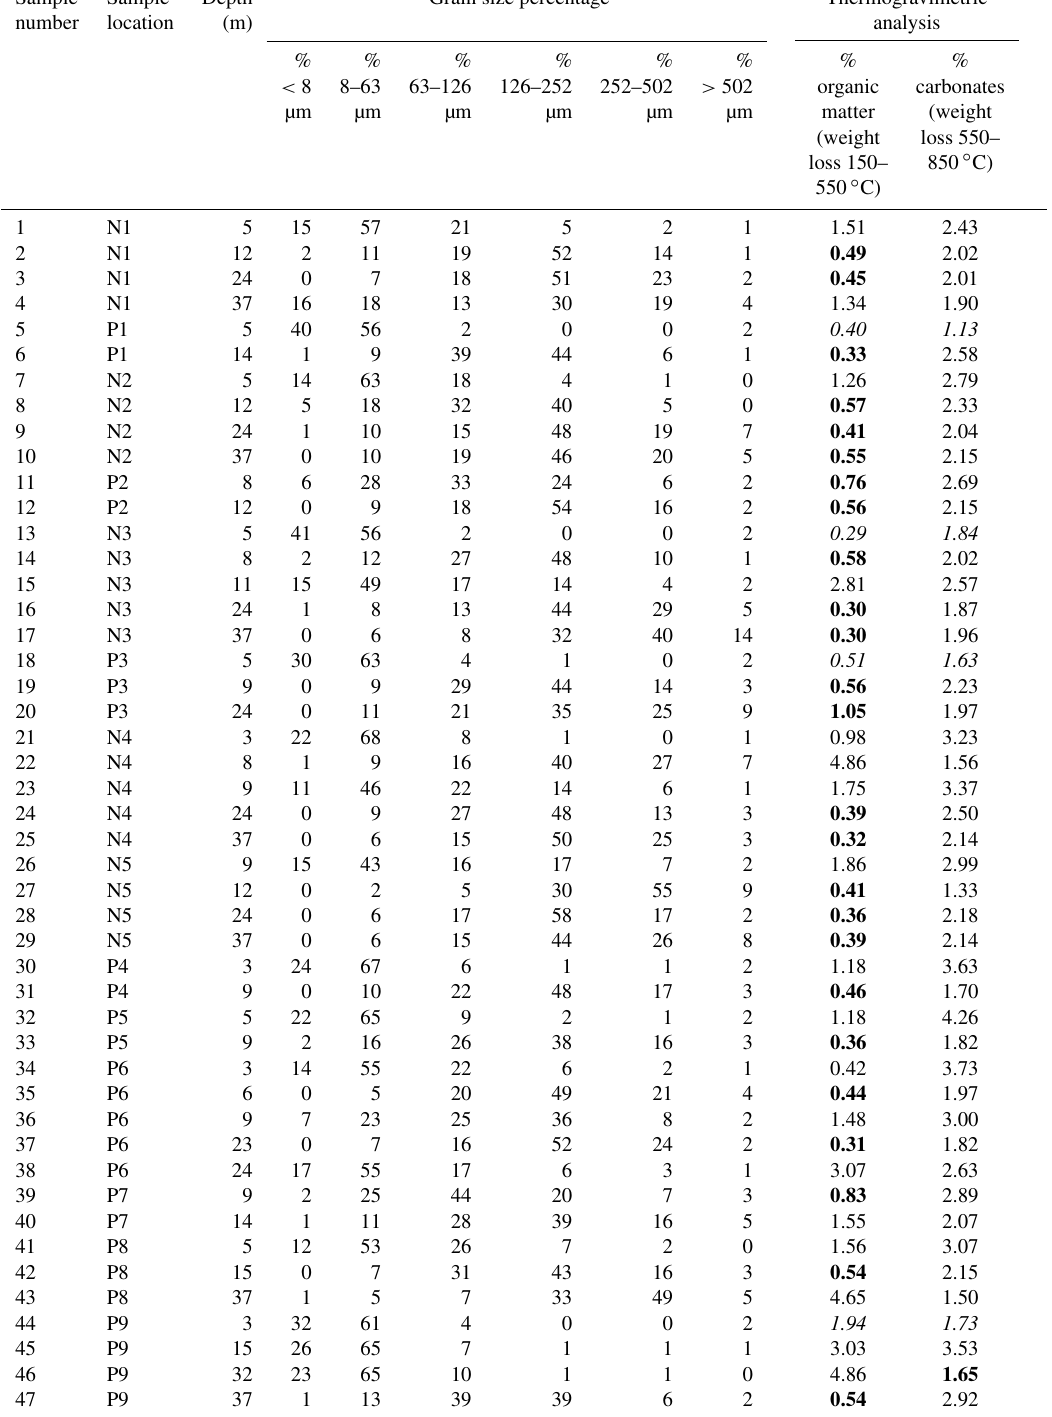
Table A1. The results of the sediment sample analyses. For the bold TGA values no clear peak was identified, indicating influence of TGA noise. For the italic TGA values the peak overlapped the border between the organic matter and the carbonate temperatures.